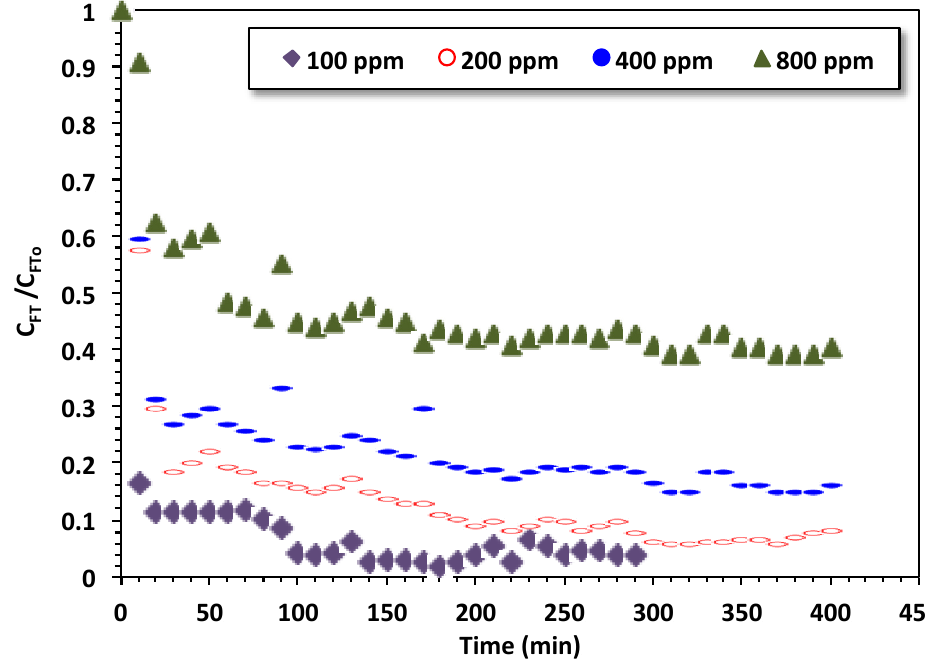
Figure 6. Flytek pesticide loading effect on the uptake concentration decline.